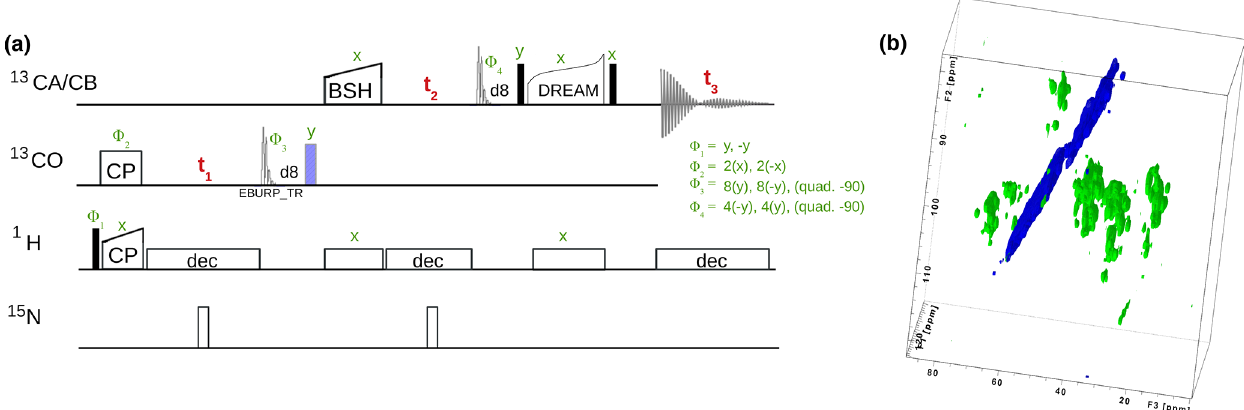
Figure 6. (a) 3D hCOCACB correlation experiment is composed of h-CO CP, CO-CA BSH-CP and CA-CB DREAM transfer steps. Filled and open bars denote π/ 2 and π pulses, respectively. Unless otherwise noted, the phase is x . The 13 C carrier frequency is changed during the pulse sequence as denoted by elements applied to either 13 CO or 13 CA / CB, respectively. (b) Experiment done on a 600MHz spectrometer with 15kHz MAS, 25 ◦ C, with a 13 C, 15 N labeled sample of a protein assembly from bacteriophage (Fraga et al.,